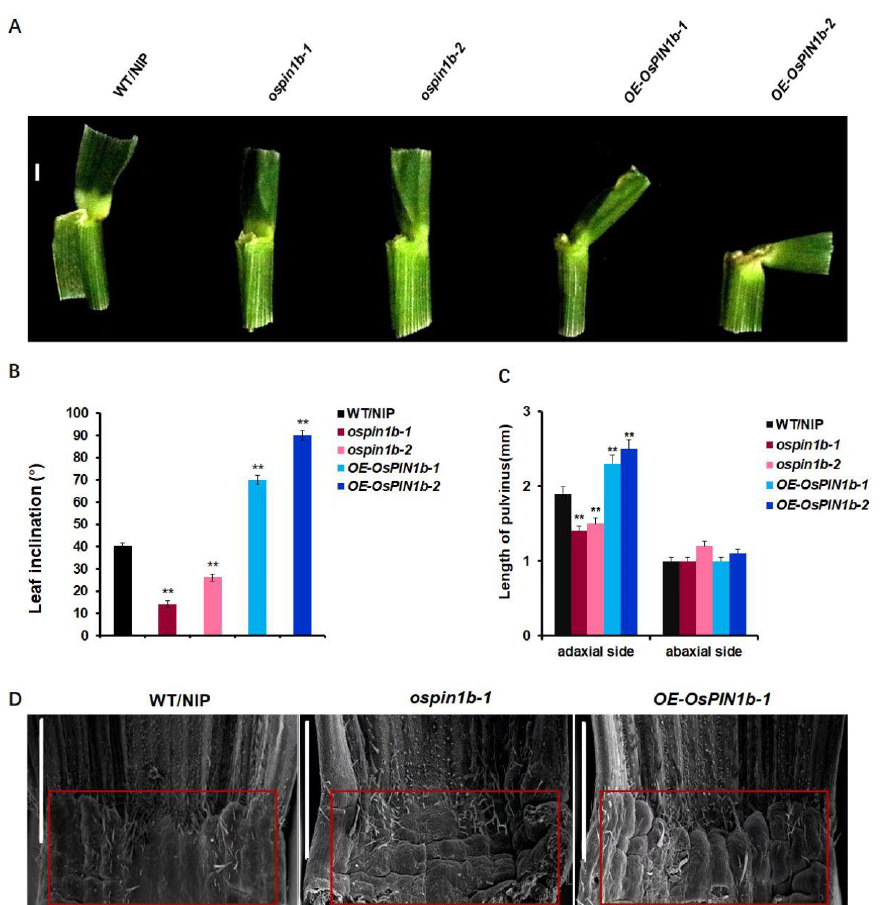
Figure 5. OsPIN1b regulates pulvinus. ( A ) Pulvinus of flag leaf of WT/NIP, ospin1b-1 , ospin1b-2, OE- OsPIN1b-1, and OE-OsPIN1b-2 . ( B ) The statistics analysis of flag leaf inclination in WT/NIP, ospin1b-1 , ospin1b-2 , OE-OsPIN1b-1, and OE-OsPIN1b-2 lines. The data are mean ± SD (n = 3). The data are mean ± SD (n = 3) and asterisk indicates the significant differences (** p < 0.01; Student’s t -test). ( C ) The statistics analysis of the adaxial and abaxial side of pulvinus length in of WT/NIP, ospin1b-1 , ospin1b-2 , OE-OsPIN1b-1, and OE-OsPIN1b-2 . Scale bar =1 mm. The data are mean ± SD (n = 3) and asterisk indicates the significant differences (** p < 0.01; Student’s t -test). ( D ) The adaxial surface of the pulvinus in WT/NIP, ospin1b-1 and OE-OsPIN1b-1 by SEM. The red box indicates cells on the adaxial surface of the pulvinus in WT/NIP, ospin1b and OE-OsPIN1b . Scale bar = 1